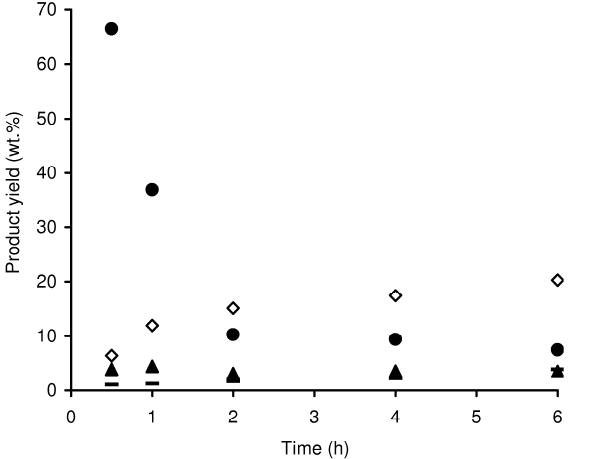
Figure 10. Reaction of inulin in the presence of Al-TUD-1 at 170 ºC: ( ● ) fructose yield; ( ▲ ) glucose yield; ( − ) mannose yield; (  ) HMF